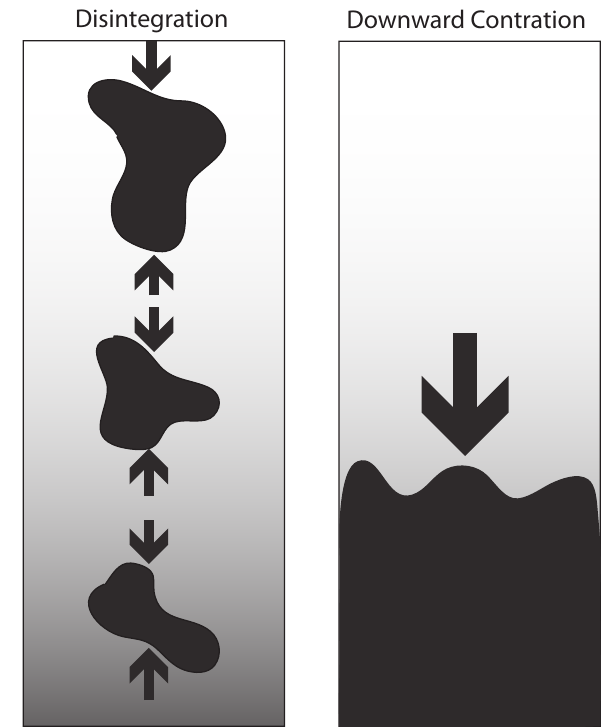
Fig. 9. Models of stream network contraction. Disintegration: the breaking up of a flowing reach into drying pools. Downward con- traction: movement of the channel head downstream.